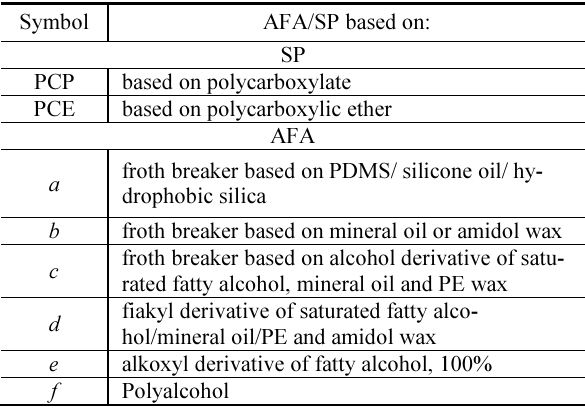
Table 2. Types of SPs and AFAs and their components